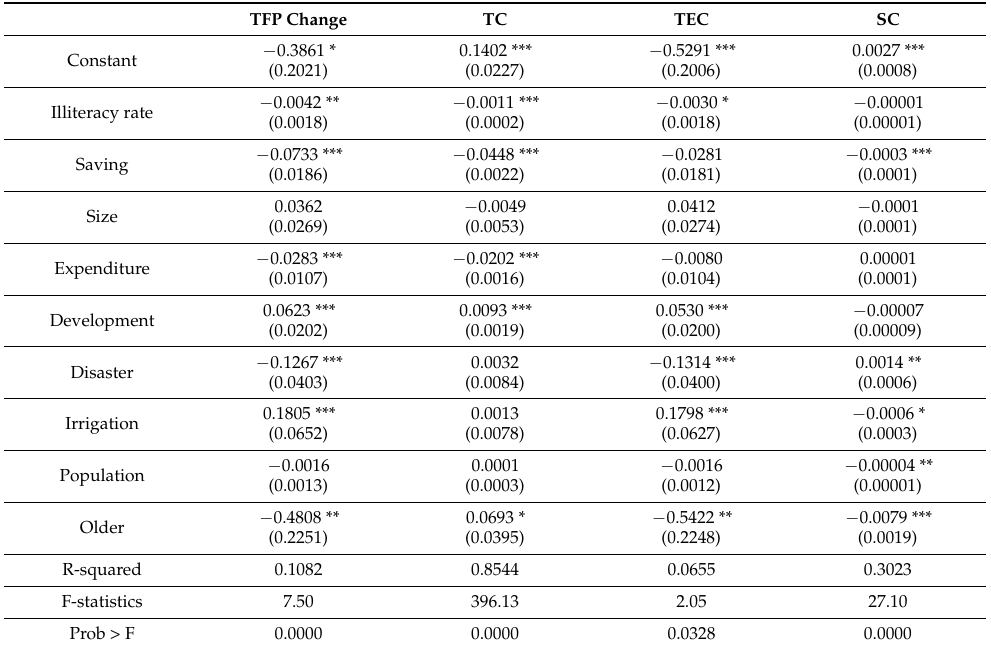
Table 4. The influence of farmers’ illiteracy on the TFP